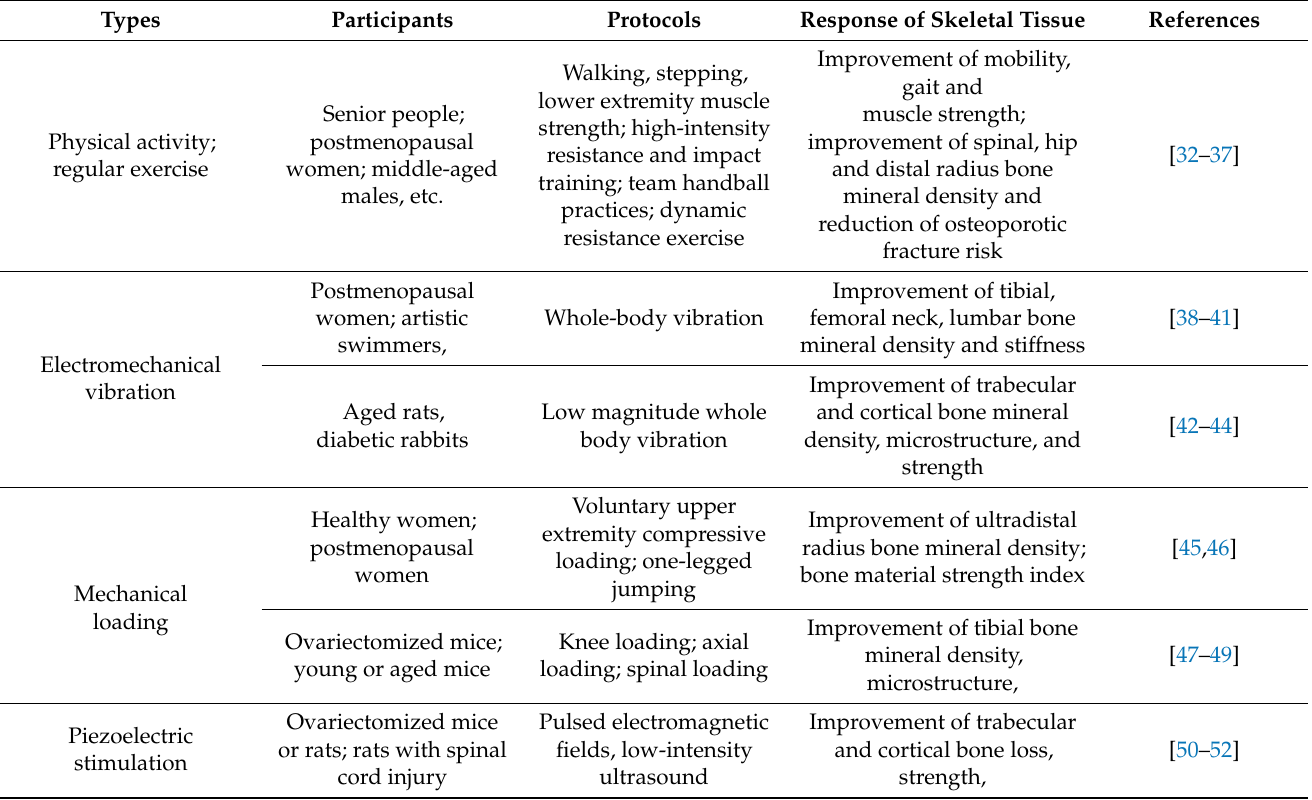
Table 1. Effects of biophysical stimulation on osteoporosis development in human and in laboratory animals.